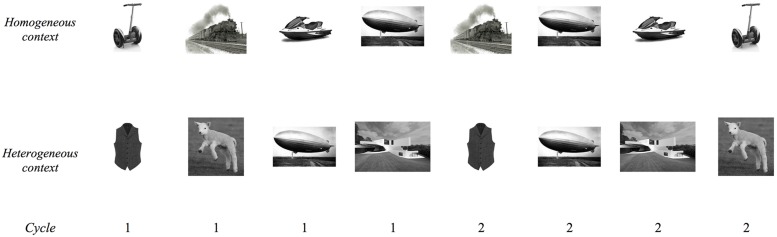
An example sequence of trials over two consecutive cycles in the blocked cyclic paradigm employed in Experiments 2 and 3.
Segway, train, jetski, airship are from the homogeneous context (vehicles category), while waistcoat, lamb, airship, house are from a heterogeneous context.